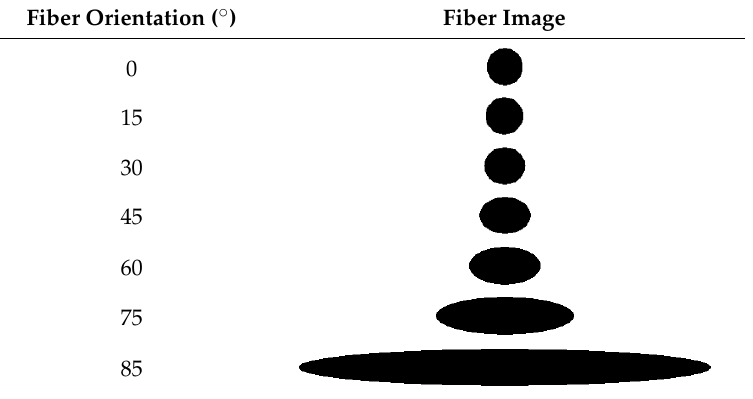
Table 1. Artificial fiber images in the cutting plane (diameter of 150 pixels).